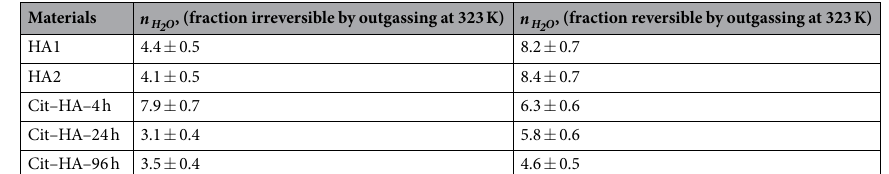
Table 3. Water surface density, n